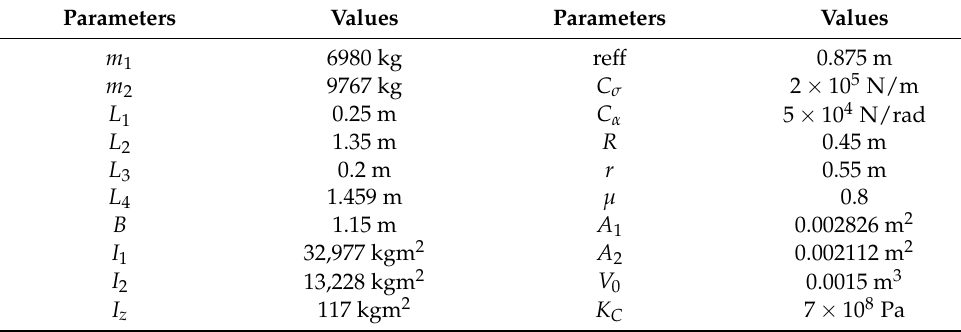
Table 1. Parameters of the vehicle dynamics